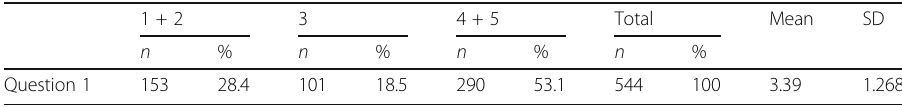
Table 3 Students ’ knowledge of the CET-4 ’ s changed status 1 + 2 3 4 + 5